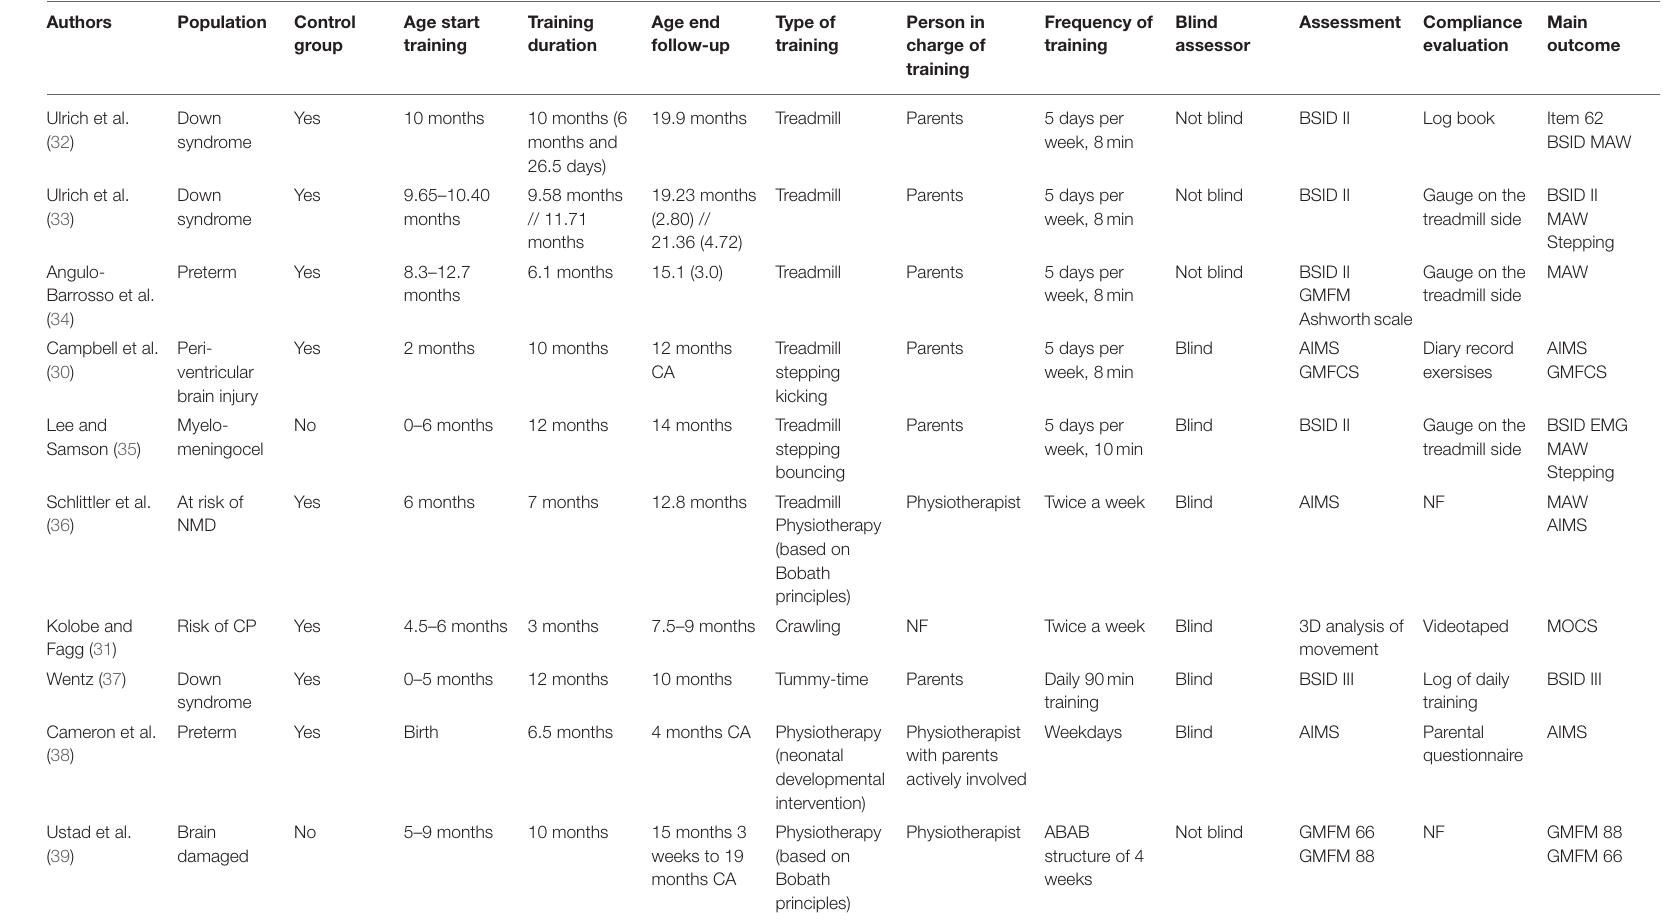
TABLE 3 | Intervention study: training protocol characteristics (“NF” abbreviation means information was not found in research